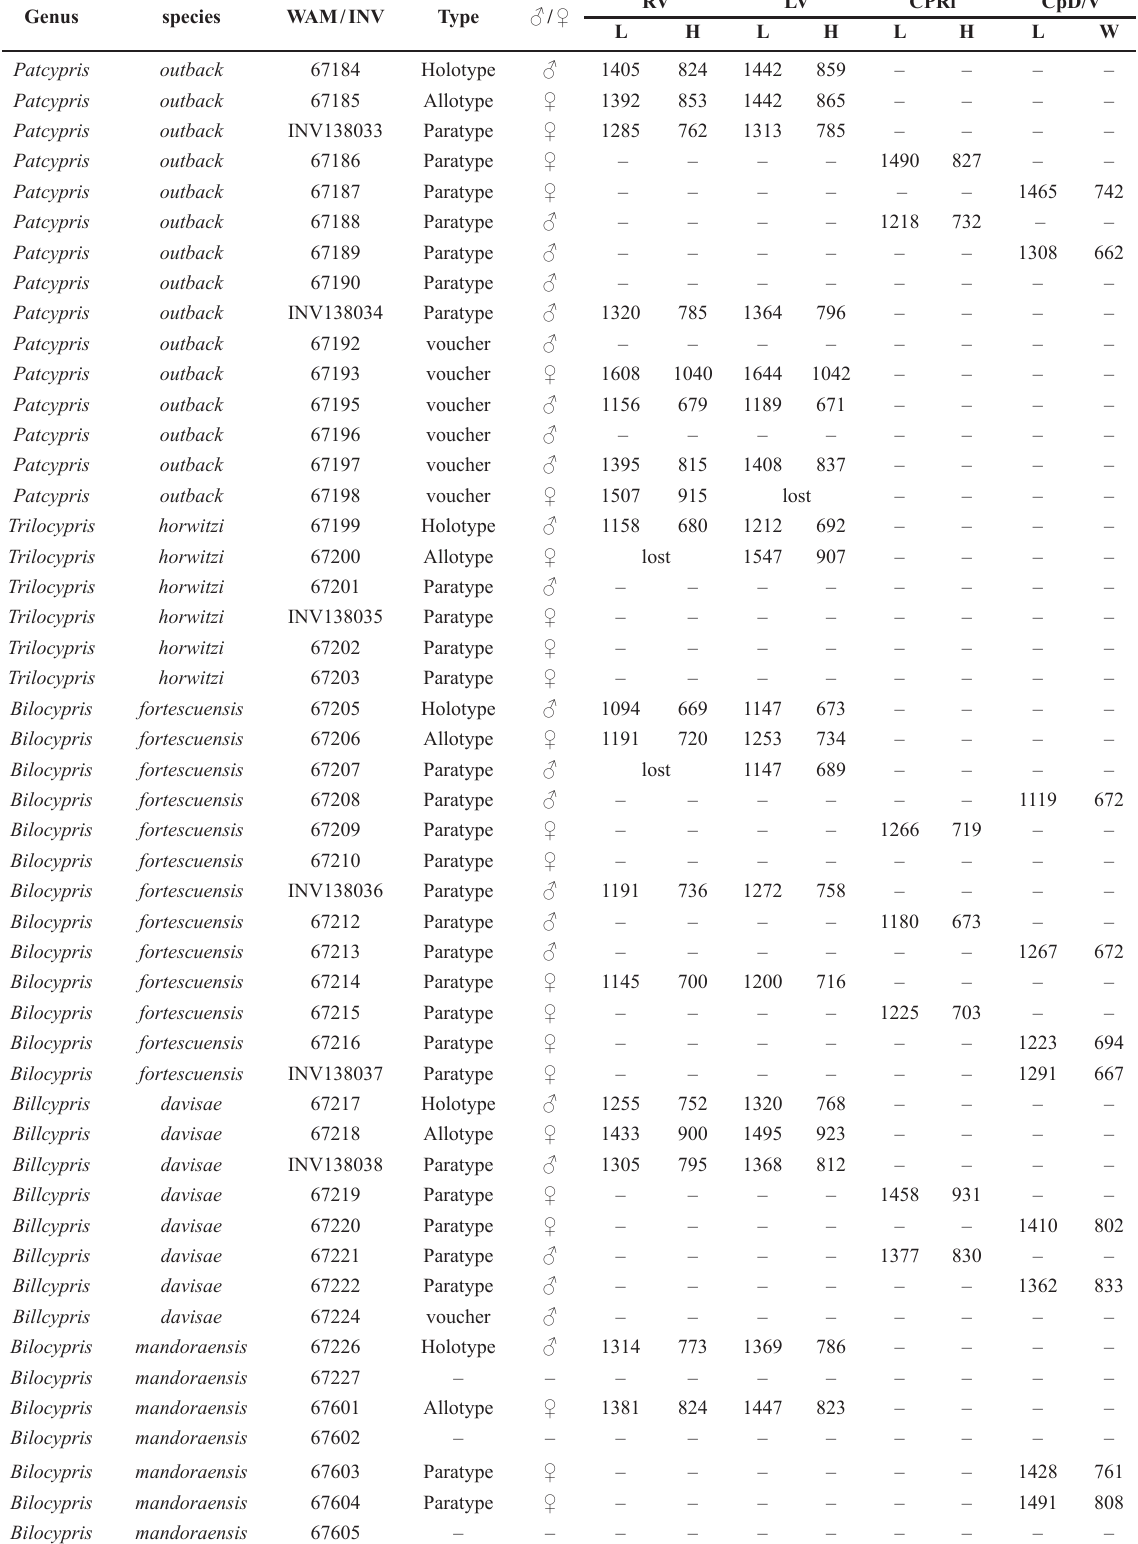
Table 1. Illustrated specimens used for the present study: museum numbers, type of specimen, gender and measurements (the latter in µm, all measured by SEM, when available). Genus